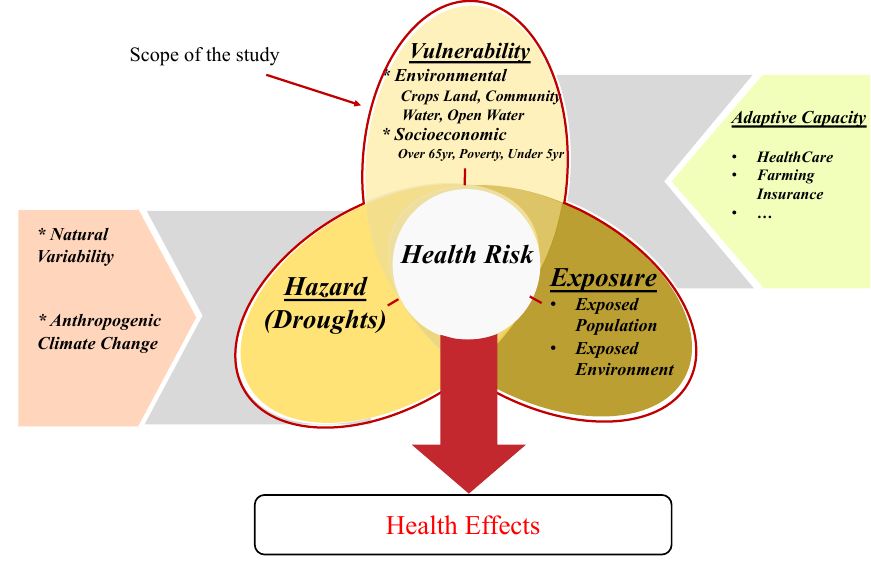
Figure 1. Adaptation of SREX framework for health risk of drought. The red boundary shows the scope of this